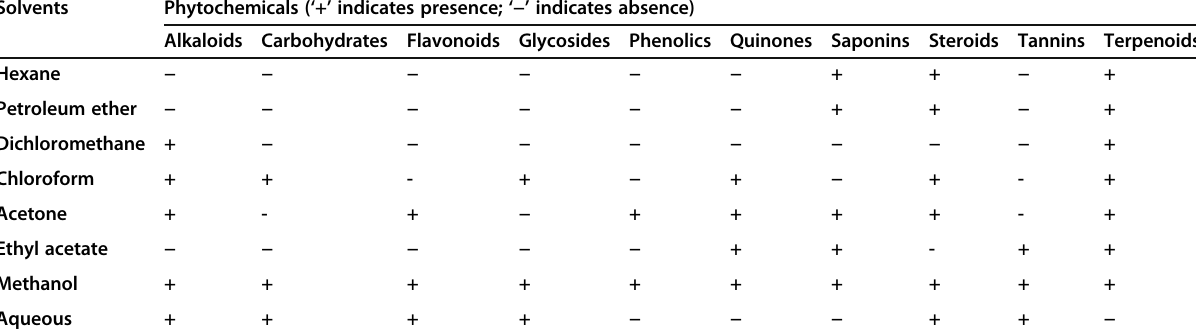
Table 1 Phytochemical analysis of Nicotiana tabacum leaf extracts Solvents Phytochemicals ( ‘ + ’ indicates presence; ‘ − ’ indicates absence) Alkaloids Carbohydrates Flavonoids Glycosides Phenolics Quinones Saponins Steroids Tannins